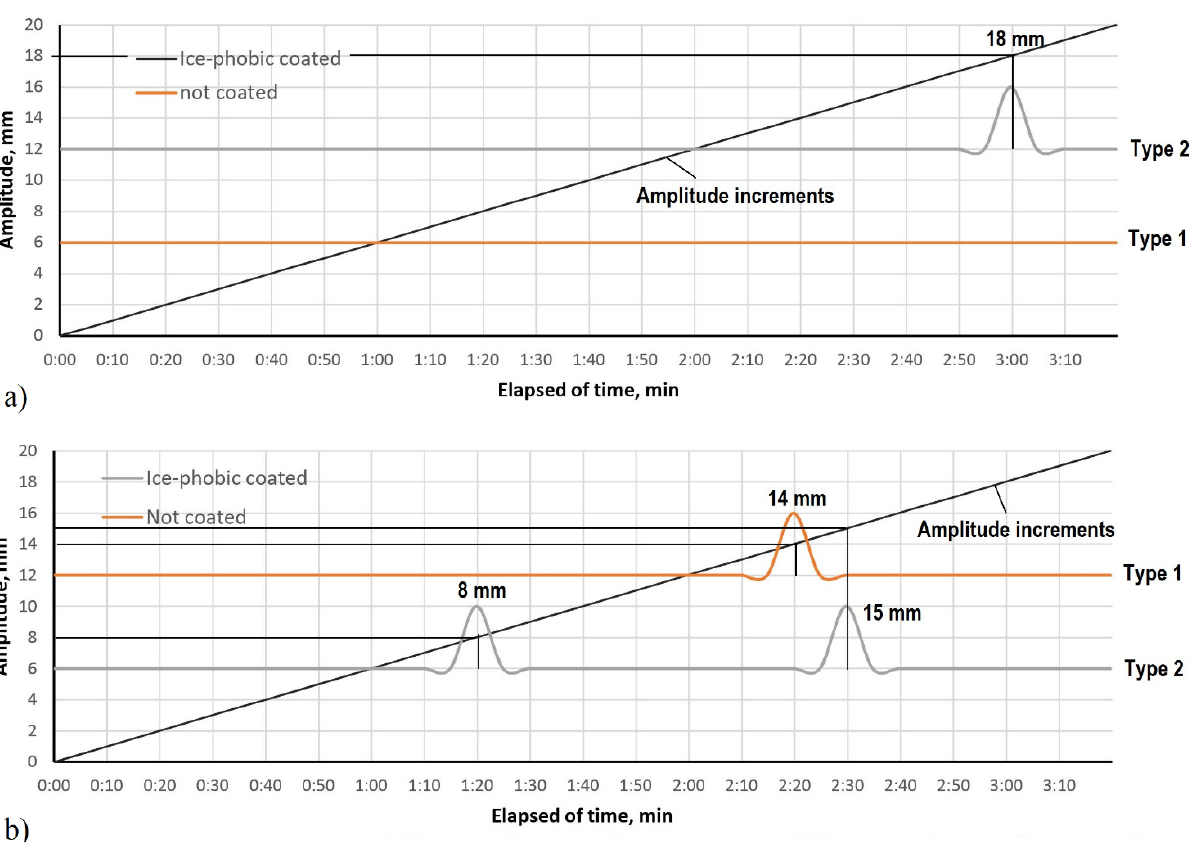
Figure 4. Results of vibration test of the samples (Type 1—not coated, Type 2—ice-phobic coated): ( a ) without prior exposure to impact load, ( b ) after exposure to impact load.